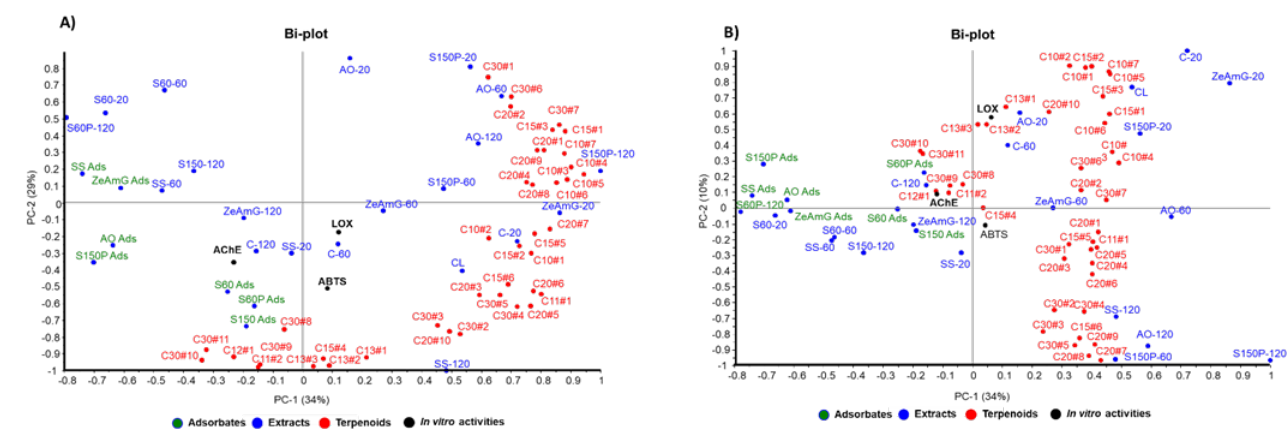
Figure 4. Principal component analysis (PCA) of the 32 extracts from olive leaves, combined with in vitro activities and types of terpenoids (C10, C15, C20, and C30). ( A ) PC-1 and PC-2 biplot, ( B ) PC-2 and PC-3 biplot.